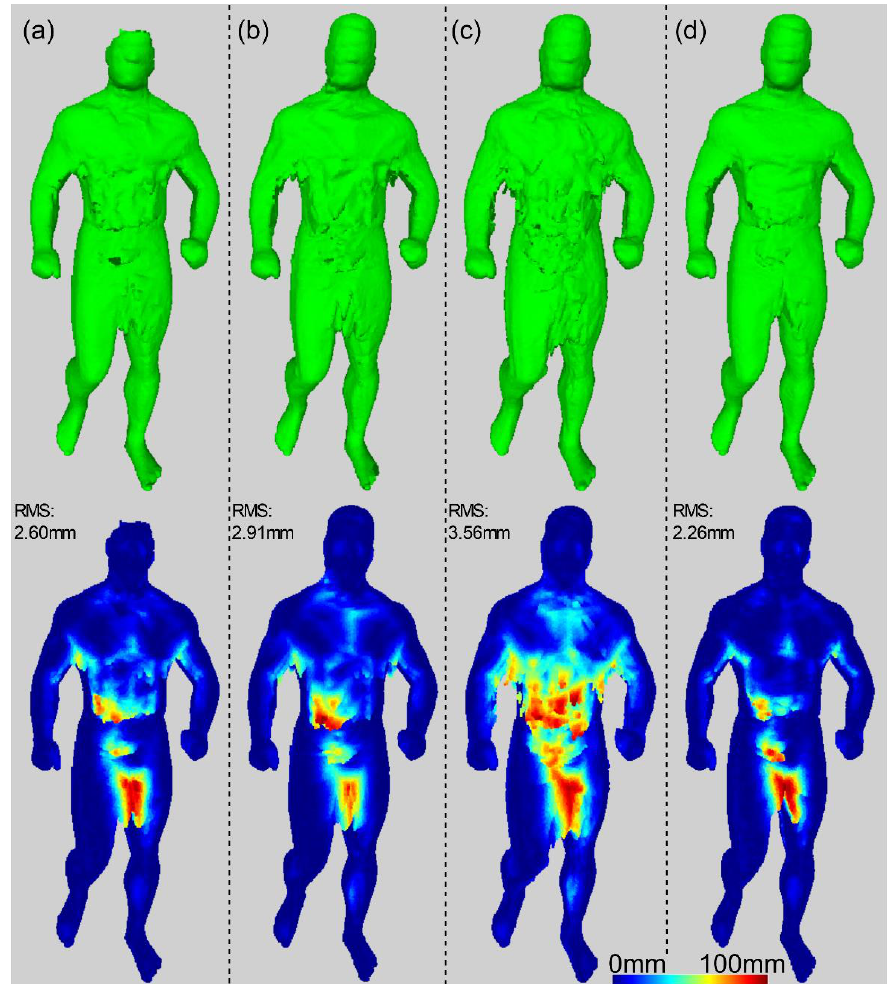
Figure 11. Comparison of the results of three different SfS reconstruction approaches and sSfS for data sample #9: ( a ) SfS for a high voting threshold for all views; ( b ) SfS for a high voting threshold for selected views; ( c ) SfS for a low voting threshold for all views; ( d ) sSfS.